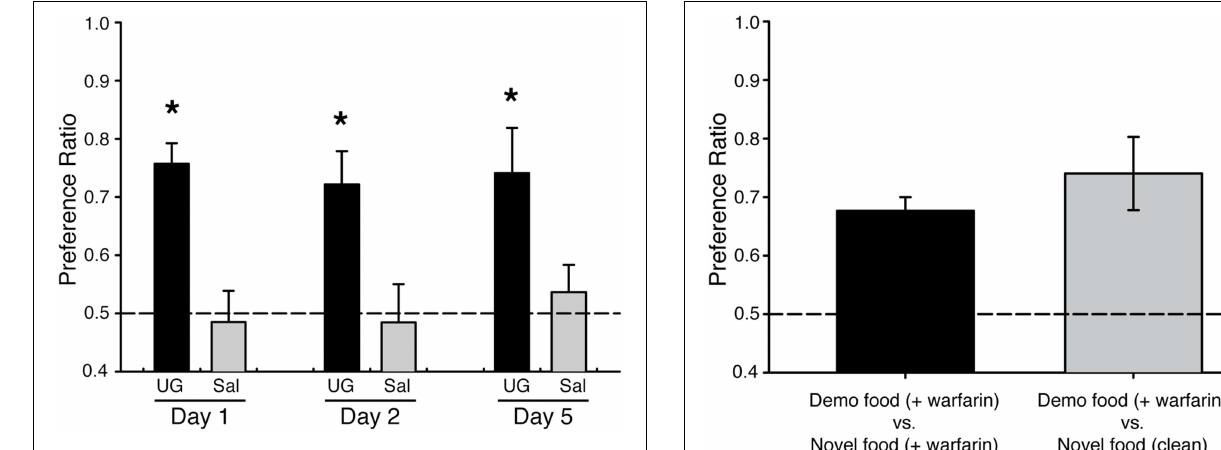
FIGURE 2 | Mice maintain UG-mediated food preferences even after ingestion of food adulterated with warfarin. C57BL/6J mice were demonstrated a food odor paired with 50nM UG (black, n = 8 ) or saline (gray, n = 8 ). Mice exposed to UG, but not saline controls, showed a significant preference for food containing the demonstrated odor and warfarin (0.025%); this preference was maintained after 5 days without additional exposure to UG. Two-Way repeated measures ANOVA on stimulus and day [ F (1 , 46) = 19 . 55 , P < 0 . 001 ] followed by Tukeys post-hoc test ( * P < 0 . 01 ). Dashed lines, no preference. Error bars, standard error of the mean. One control mouse was removed from the study prior to Day 5 due to apparent significant distress.